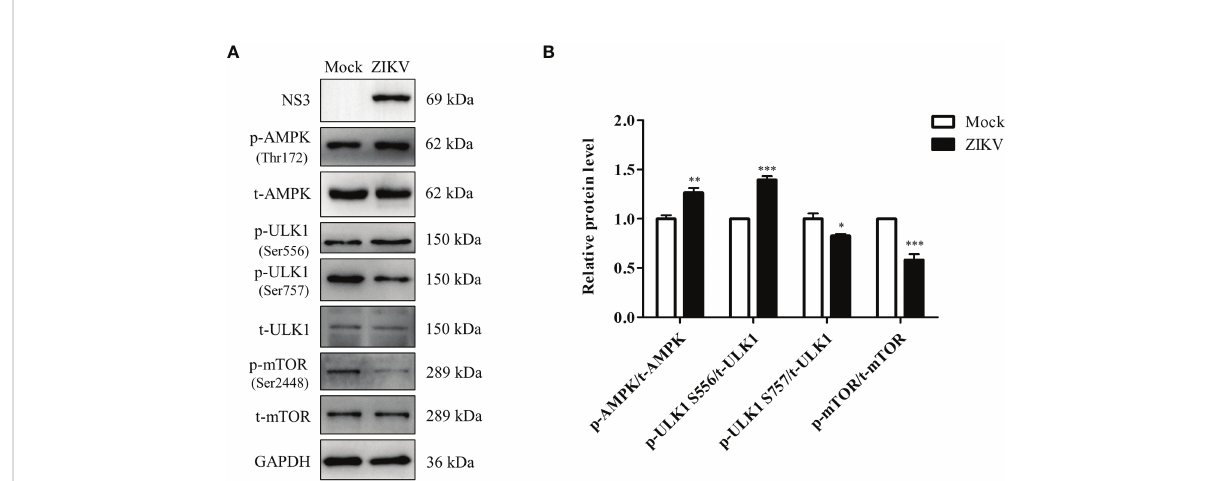
FIGURE 5 ZIKV infection activates the AMPK/ULK1 and AMPK/mTOR/ULK1 signaling pathways in Huh7 cells. Huh7 were infected with ZIKV at an MOI of 0.5 or mock-treated. Samples were collected at 24 h after ZIKV infection and subjected to western blot analysis. (A) Western blot analysis of the levels of AMPK, ULK1, mTOR, and their corresponding phosphorylated forms. GAPDH was used as a loading control. (B) The intensity band ratios of phosphorylated AMPK, ULK1, and mTOR to respective total protein levels were measured using densitometry. Data are presented as the mean ± SD from triplicates. * p < 0.05, ** p < 0.01, *** p <